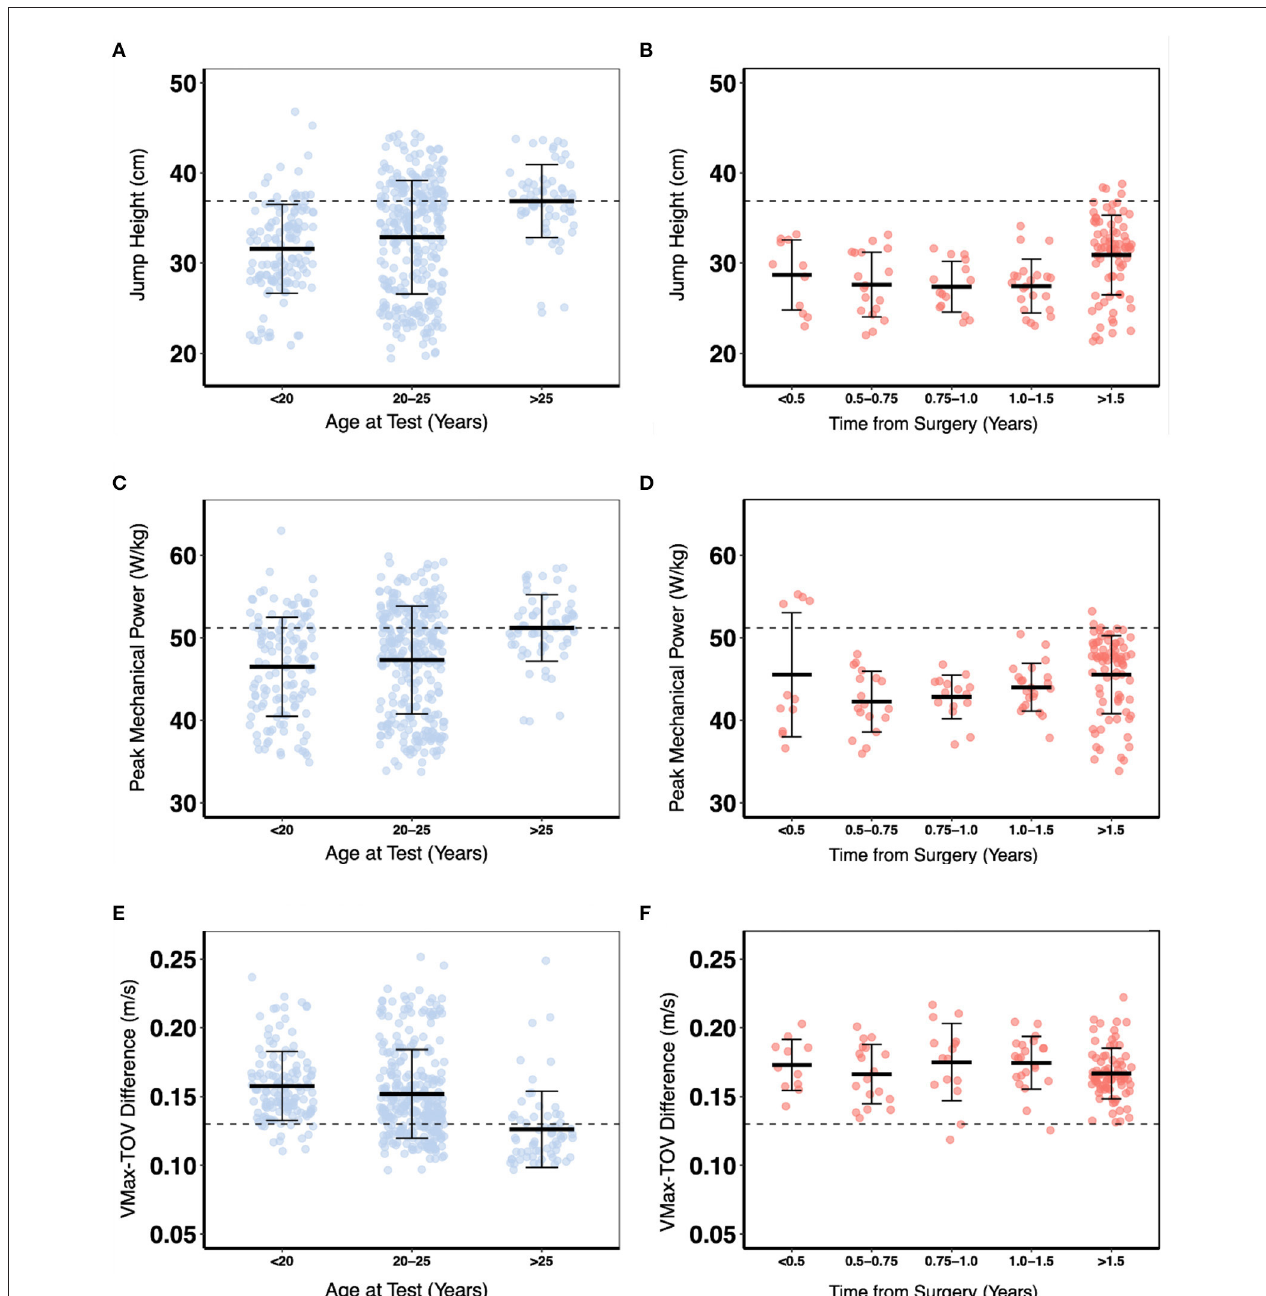
FIGURE 2 | A descriptive comparison of concentric phase measures for non-injured control vs. age and anterior cruciate ligament reconstructed (ACLR) skiers vs. time from surgery. The black dashed line indicates the mean value for non-injured controls > 25 years of age. Vmax-TOV Difference– 1 maximum velocity of the body center of mass and takeoff velocity. (A) Jump height control. (B) Jump height ACLR. (C) Peak mechanical power control. (D) Peak mechanical power ACLR. (E) Max velocity-takeoff velocity difference control. (F) Max velocity-takeoff velocity difference